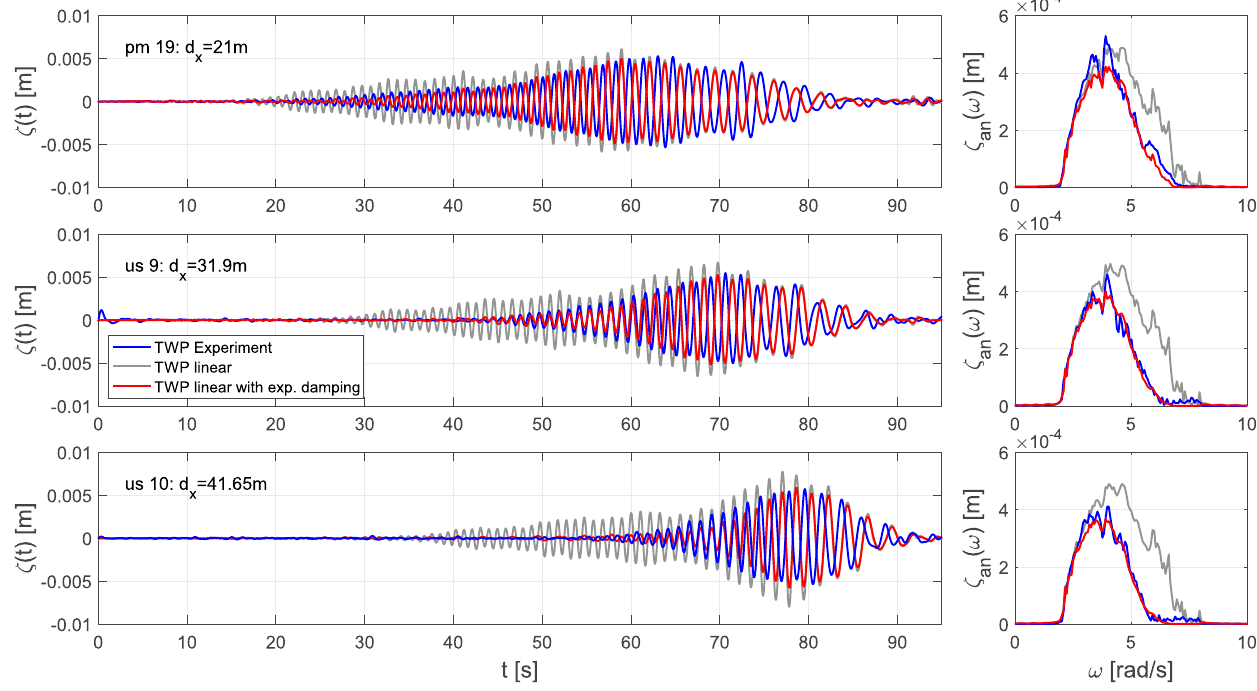
Figure 6. Comparison between measured vertical displacement of the ice and analytical solution of the linear theory for selected locations. The results in the time domain are shown on the left-hand side and the corresponding amplitude spectra are compared on the right hand side. For linear theory, results for the classical approach as well as for the extended approach by taking the measured damping into account are